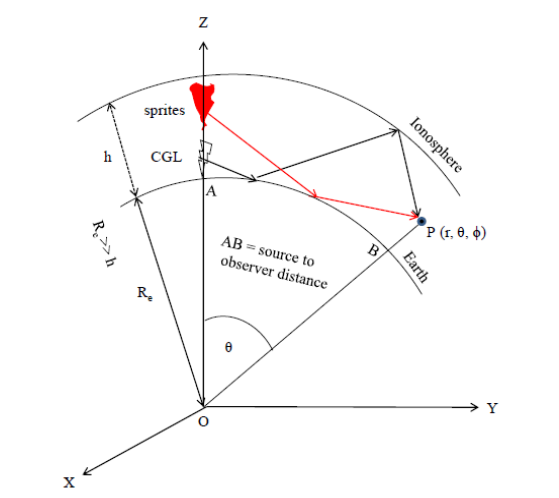
Figure 1: Schematic diagram of calculation model and coordinate system. The ELF radiation from red sprites and cloud-to-ground lightning (CGL) travel in the Earth- ionosphere waveguide and observed at point P(r,θ,ϕ). Here, the observation point is on the surface of earth i.e. r=R e .